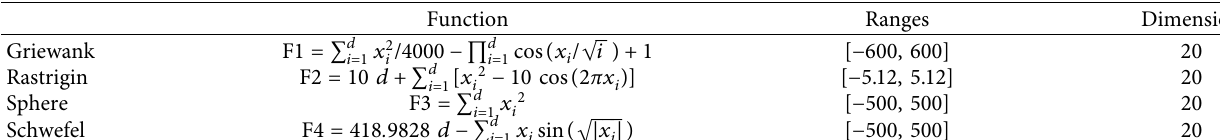
Table 2: Four test functions. Function Ranges Dimension